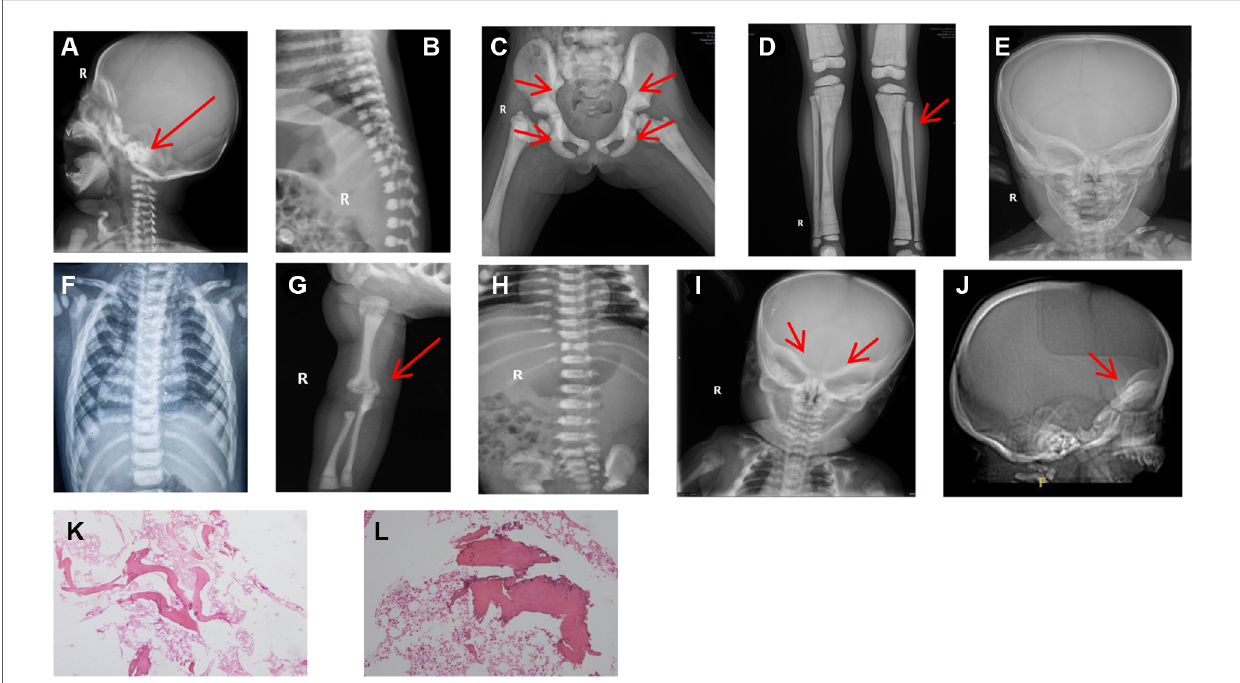
FIGURE 2 Patient x-rays. ( A ) Patient 1: signi fi cant increase in bone density observed at skull base (arrow). ( B ) Patient 1: vertebral endplate showed typical “ sandwich vertebrae ” appearance. ( C ) Patient 2: generalized increase in bone density and typical pelvic wing “ bone-in-bone ” evident (arrow); high-bone density under the cartilage in the pelvis (arrow). ( D ) Patient 2: diffusely increased bone density con fi rmed and osteopetrosis in the distal metaphysis of the femur showed typical “ bone-in-bone ” appearance (arrow). ( E ) Patient 3: head mass was identi fi ed with a hard quality and swelling around the frame and uneven bone density detected. ( F ) Patient 3: vertebral endplate showed typical “ sandwich vertebrae ” appearance. ( G ) Patient 4: diffuse increase in bone density at the upper radius (arrow), showing “ bone-in-bone ” appearance. ( H ) Patient 4: vertebral endplate appeared thickened, with “ sandwich vertebrae ” . ( I ) Patient 4: observed osteopetrosis in skull base (arrow). ( J ) Patient 4: lateral skull computerized tomographyshowing increased thickness of skull base (arrow). ( K-L ) Patient 3: marrow biopsy results showed partial calci fi cation of trabecular bone; HE staining × 40 ( K ); HE staining × 100 ( L ).